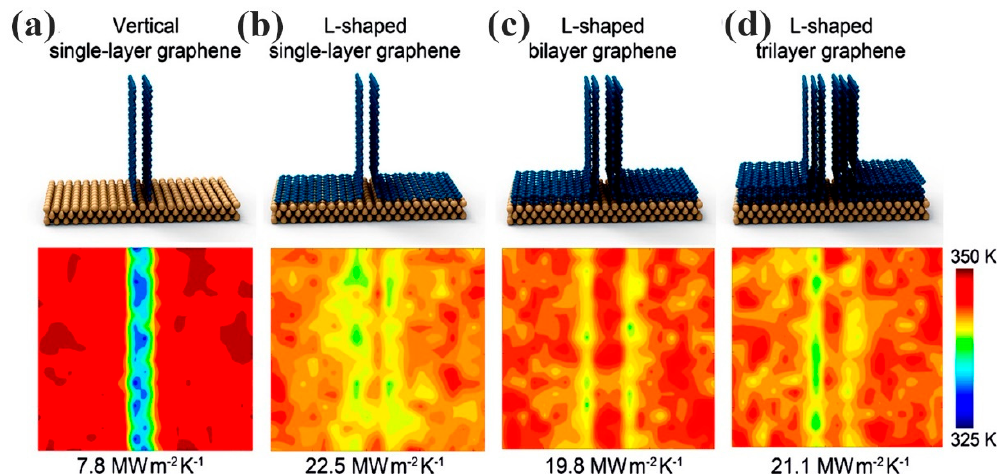
Figure 25. ( a ) Vertical graphene, and L-shaped ( b ) single-layer, ( c ) bilayer, and ( d ) tri-layer graphene, based on nonequilibrium molecular dynamics (NEMD) simulations of the effective contact thermal conductance (reproduced with permission from [193]).